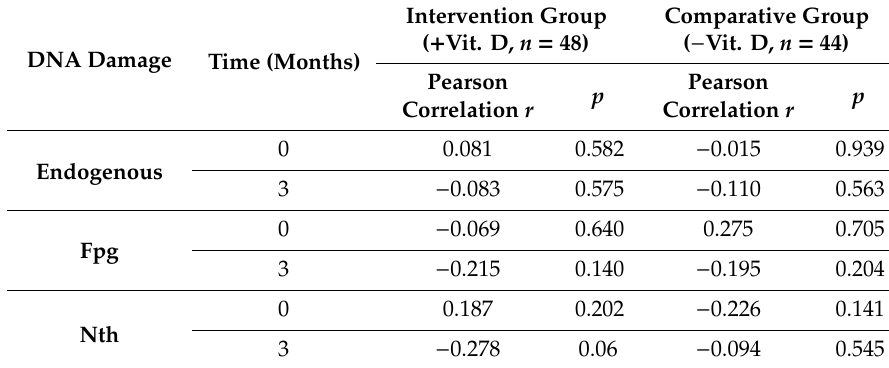
Table 3. The correlation between vitamin D and endogenous and oxidative DNA damage in the intervention group ( + Vit. D) and comparative group ( − Vit. D) at baseline (0) and after three months of vitamin D supplementation (3). The analysis was performed by Pearson’s correlation test.